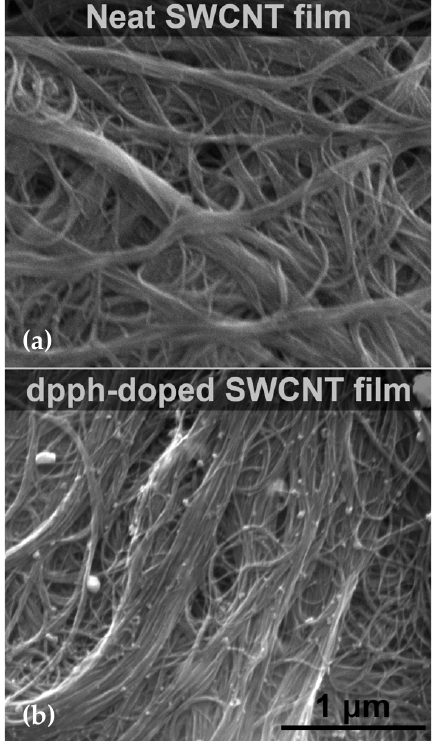
Figure 3. SEM micrographs of ( a ) neat SWCNT film and ( b ) upon doping with dpph.